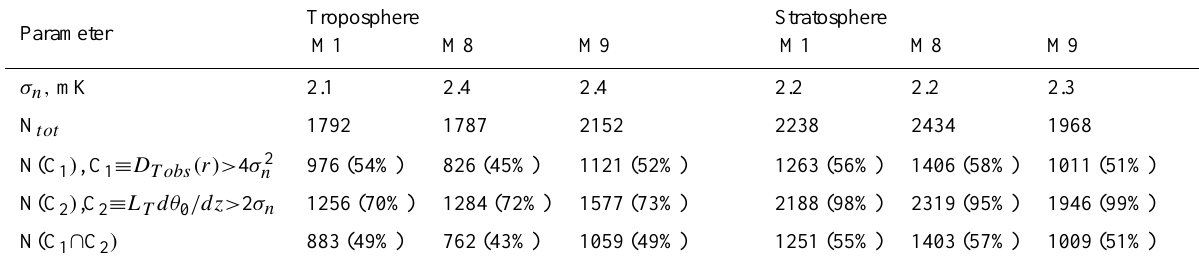
Table 1. Noise standard deviations and numbers of selected data points according to different criteria for flights M1, M8 and M9. Troposphere Parameter